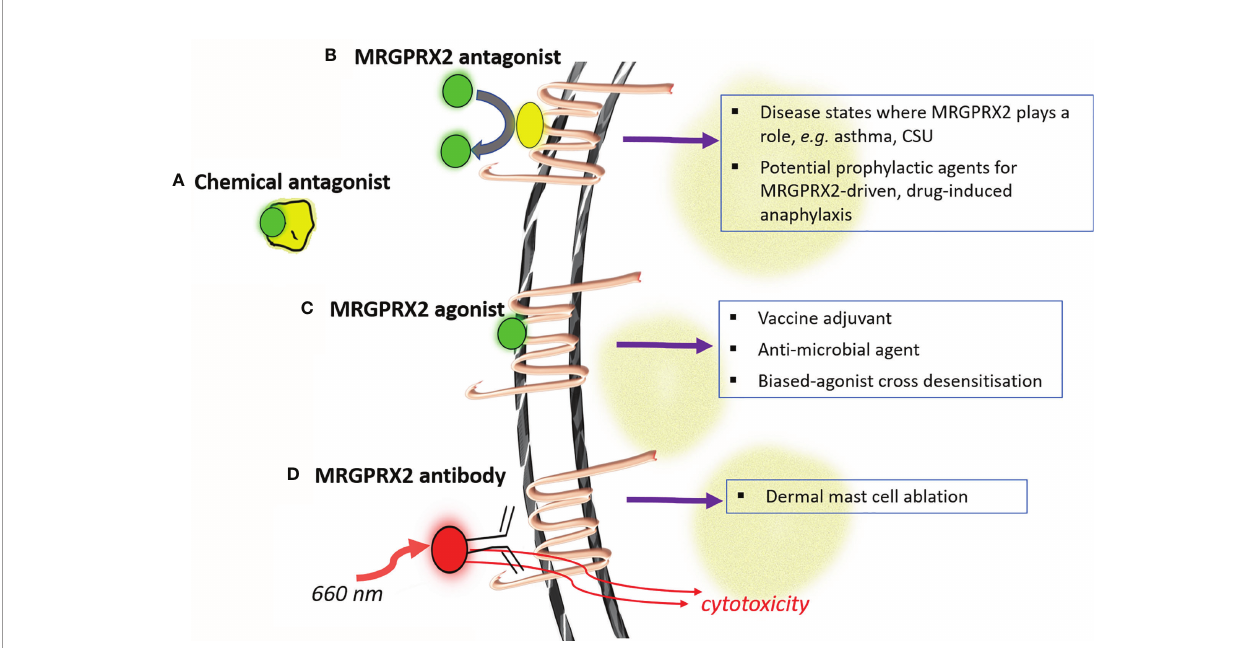
FIGURE 2 | Modulating MRGPRX2 for putative therapeutic bene fi t. Four major strategies have been advanced for modulating the activity of mast cells through MRGPRX2 (labeled a-d). Antagonism at MRGPRX2 can be harnessed at both the ligand (A) and receptor (B) levels whilst complete or signaling-biased MRGPRX2 agonists (C) could be used in a number of settings to modulate immunity. Considerations around the safety of this later approach would be clari fi ed through better understanding if/how MRGPRX2 contributes to acute drug-induced anaphylaxis. The relatively unique and high-expression levels of MRGPRX2 in skin mast cells has also been proposed as a strategy for antibody-targeted selective mast cell ablation (D) . (CSU- chronic spontaneous